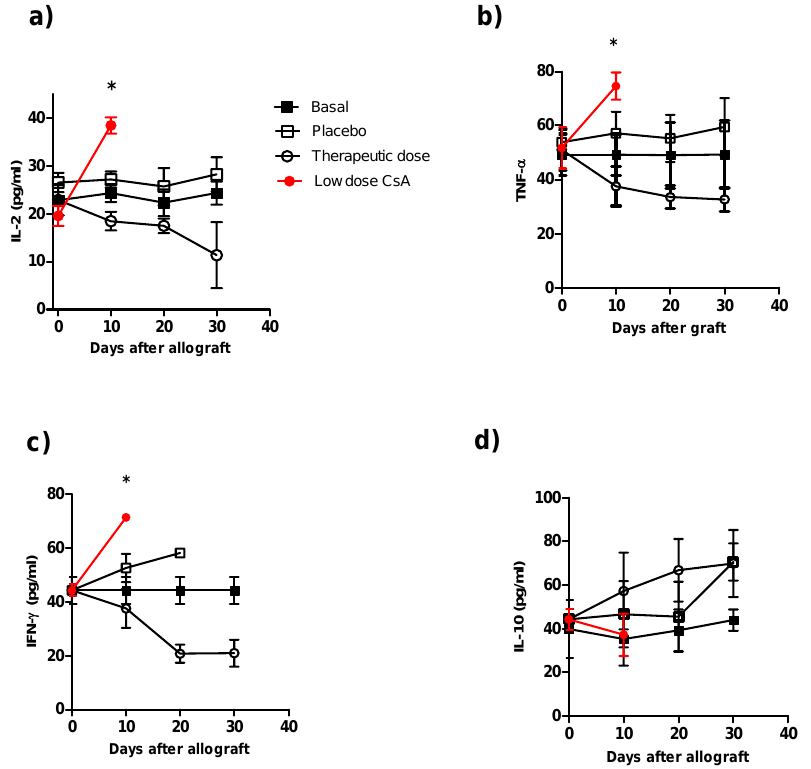
Figure 3. Kinetics of cytokine production during course of allograft in ICR mice receiving different treatment of CsA. Individual mice were bleeding at different times after skin allograft, and sera were processed for cytokine detection by ELISA a ) IL-2 detection, b ) TNF- α detection, c ) IFN- γ detection and d ) IL-10 detection in sera of from animals receiving allografts and CsA treatment. The data are the mean of two independent experiments at each time point. An asterisk indicates statistically significant (*P < 0.05) differences between the groups receiving CsA with respect to basal and